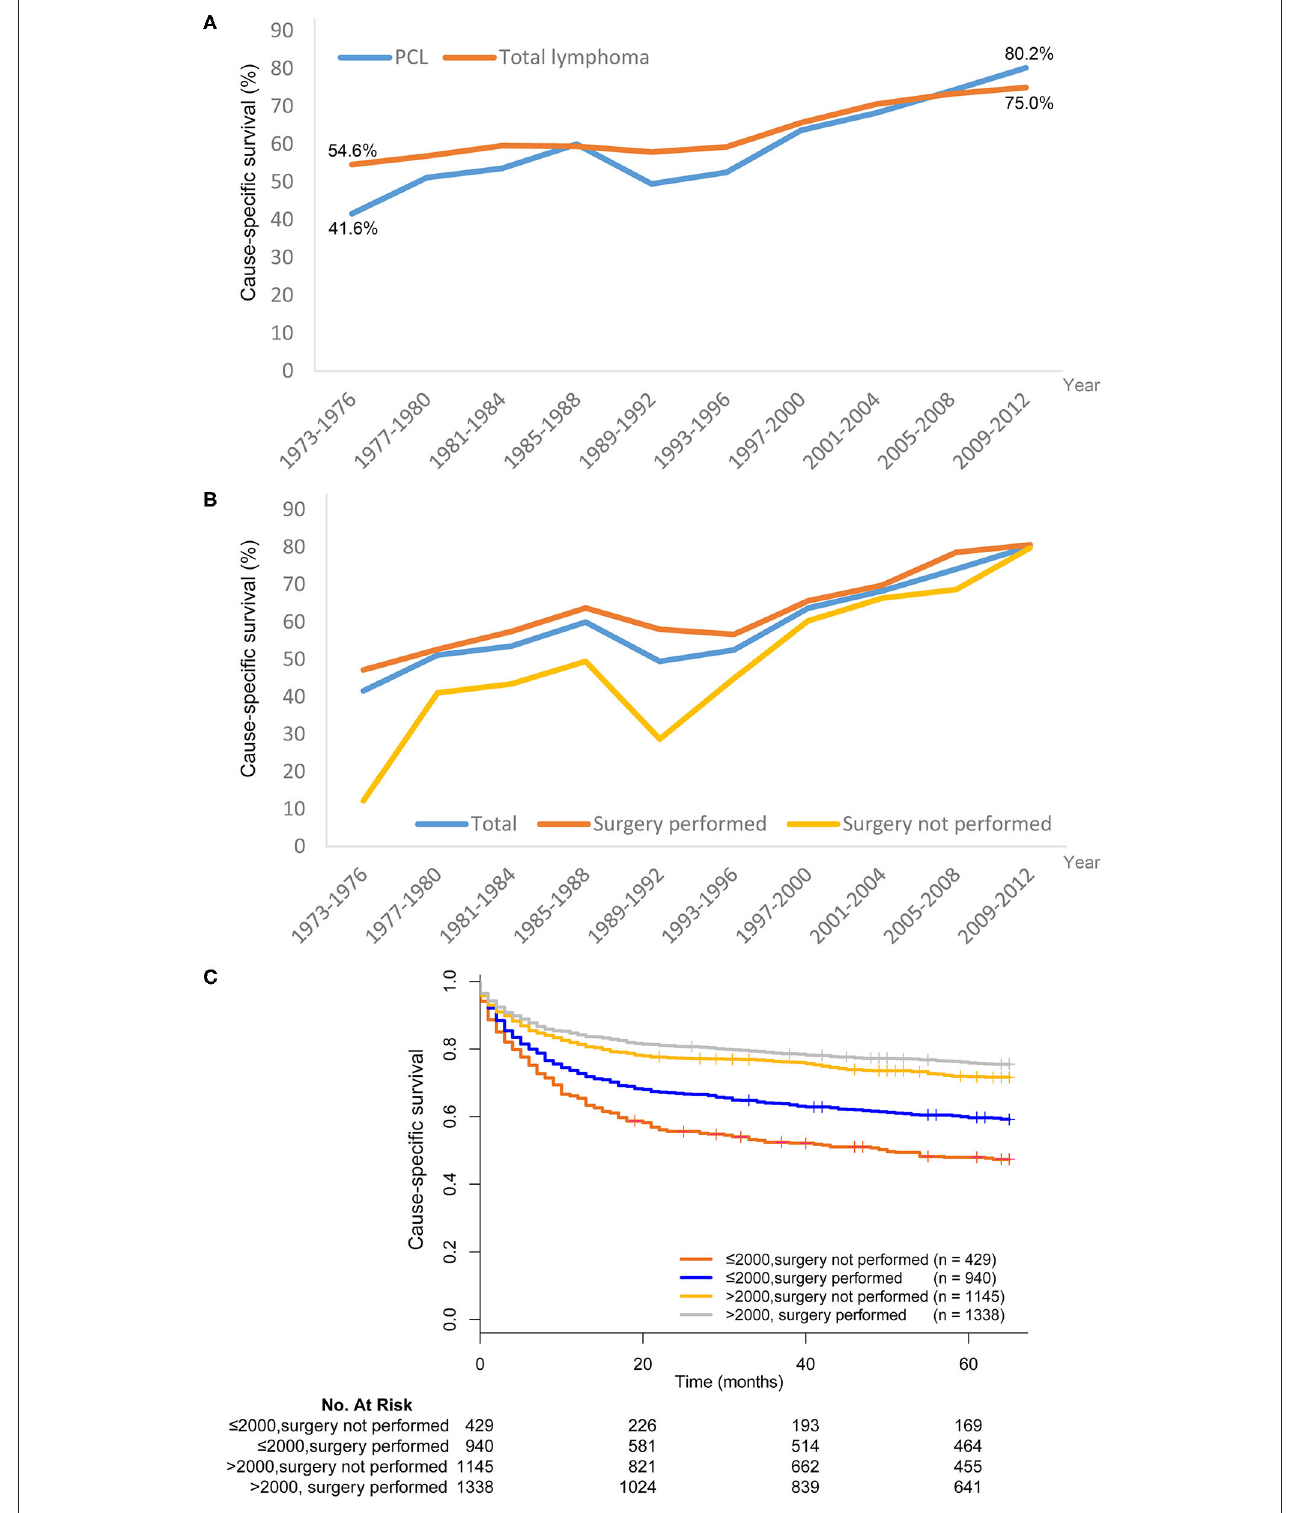
FIGURE 4 | Trends in cause-specific survival (CSS) of lymphoma in SEER 18 registries, 1973–2012. (A) The CSS was improved in both primary colorectal lymphoma (PCL) and total lymphoma. (B) Patients who received surgical resection of PCL generally had better CSS than those without surgical resection. (C) The superiority of surgical resection was significantly reduced after year